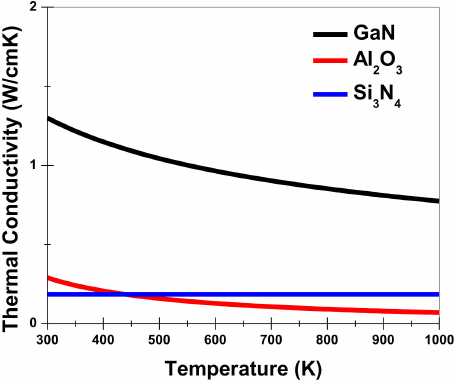
Figure 4. Thermal conductivities for GaN, Al 2 O 3 , and Si 3 N 4 with respect to